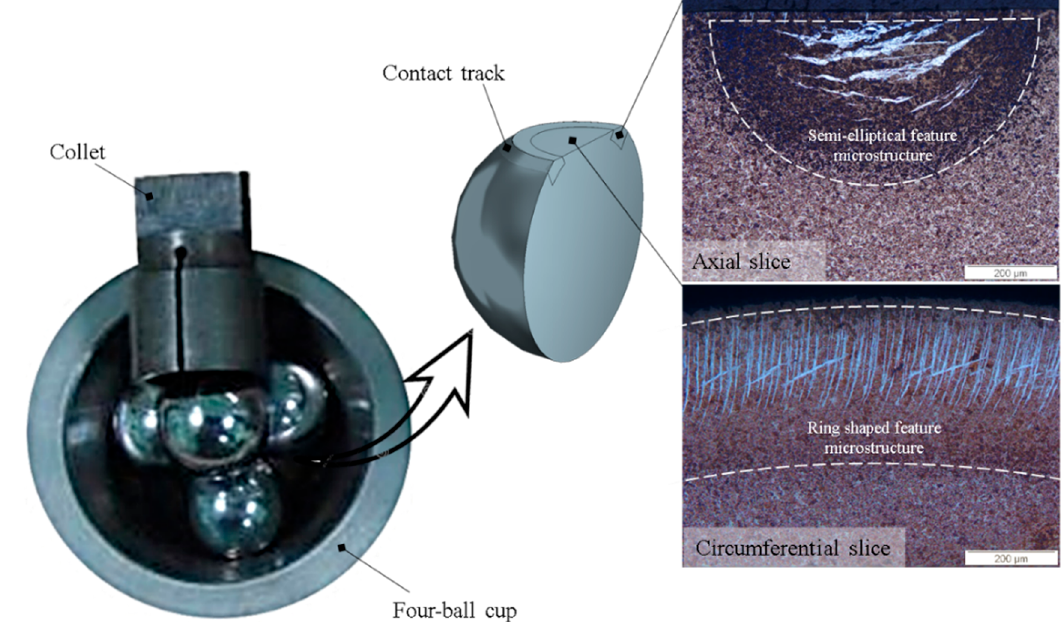
Figure 1. Rolling contact fatigue testing in a rotary tribometer.